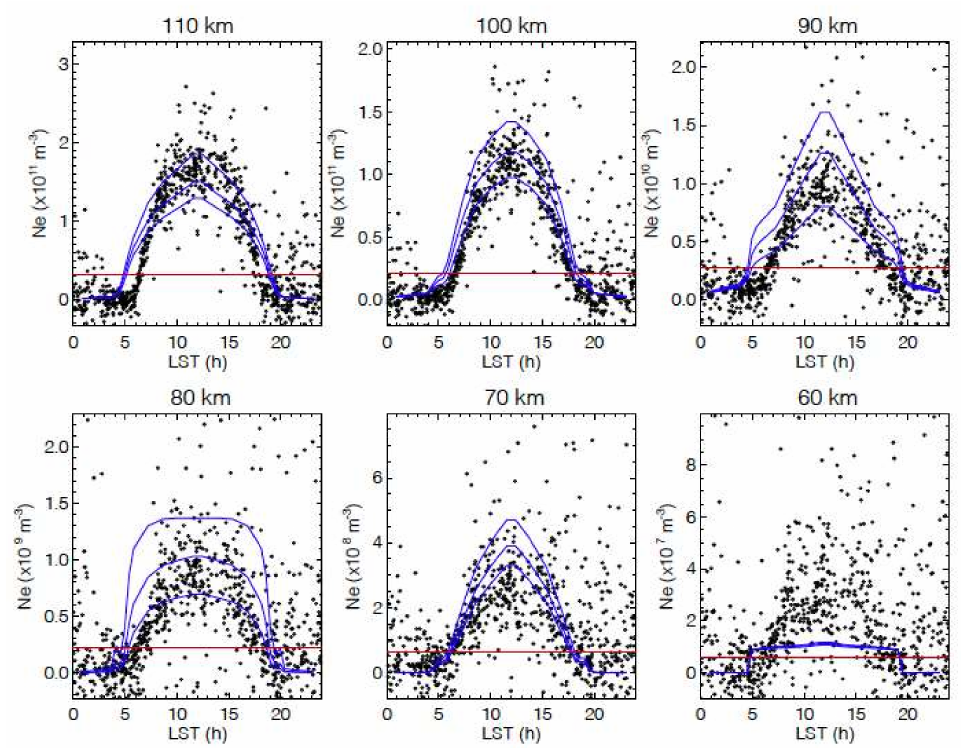
Figure 5. COSMIC-2 N e retrievals in the tropics (5 ◦ S–5 ◦ N) as a function of local time from 1 January 2021. The N e value in the linearization state vector x 0 is the red line, and the FIRI models for three tabulated F10.7 (75, 130, 200 sfu) levels are the blue